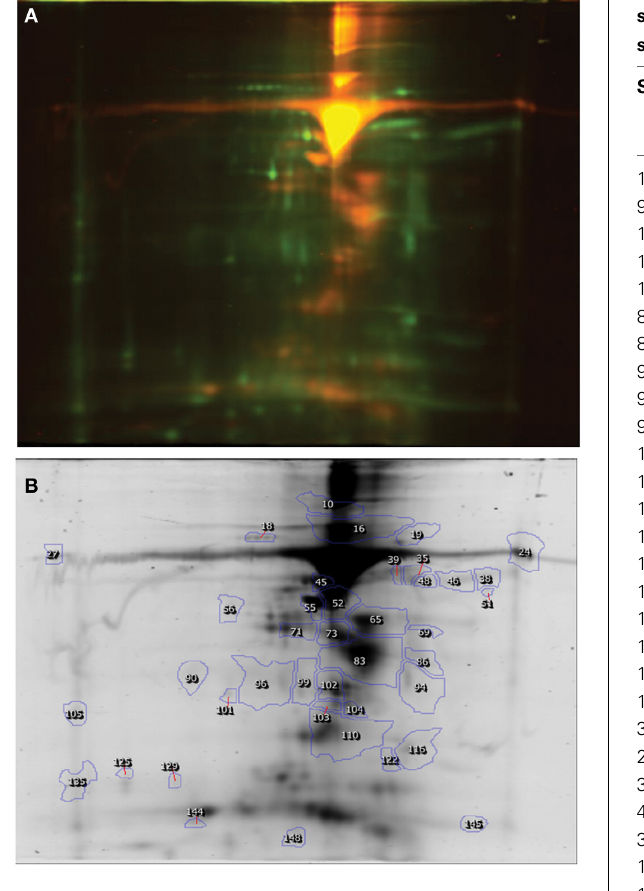
FIGURE 1 | DIGE image of Spermatogenic cell proteins (Holstein Friesian × Karan Fries). (A) DIGE image, (B) Differentially expressed spots.